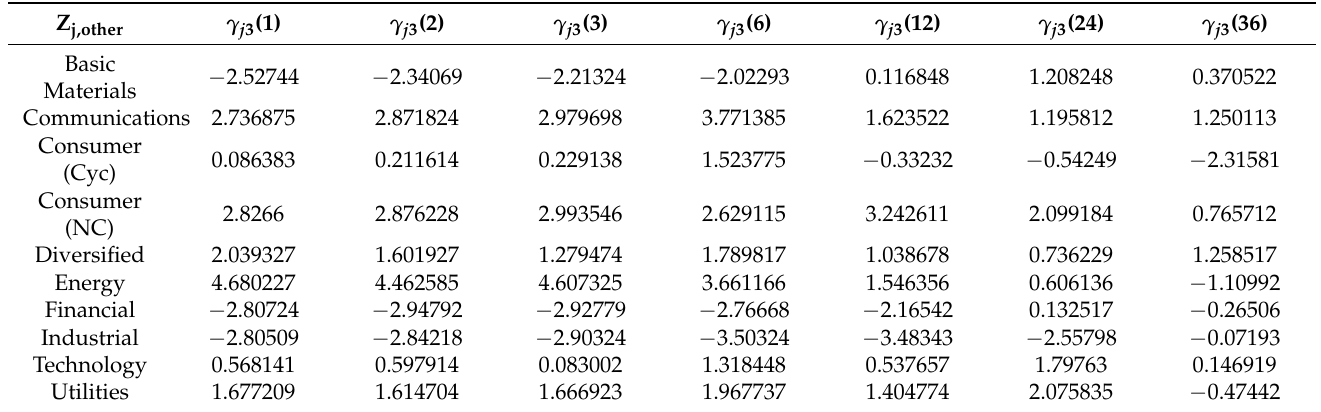
Table 4. Maximum pseudo-likelihood estimates for γ j 3 (l) .